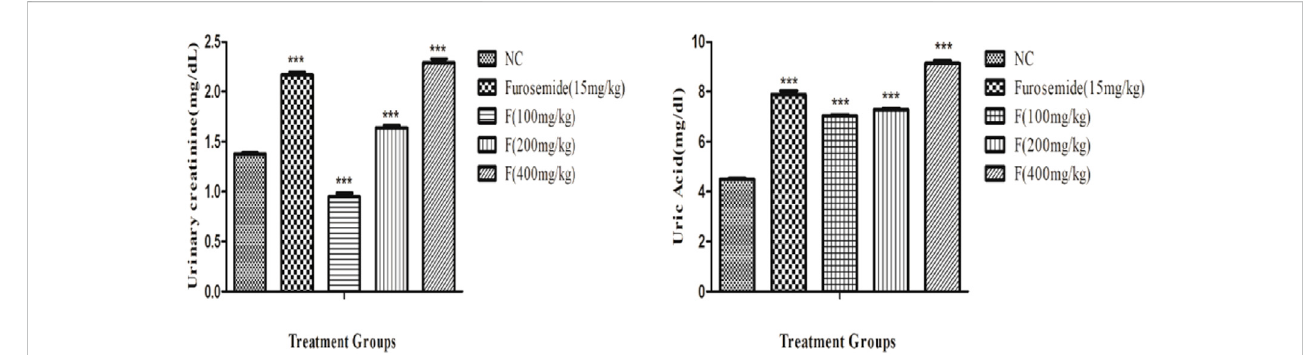
FIGURE 4 Effect of different doses of fenchone on urinary creatinine and uric acid excretion where furosemide was taken as the standard drug. Data are stated as mean ± SEM, N = 6. *** p < .001 represents a signi fi cant increase, while ’’’ p < .001 represents a signi fi cant decrease vs. normal control.